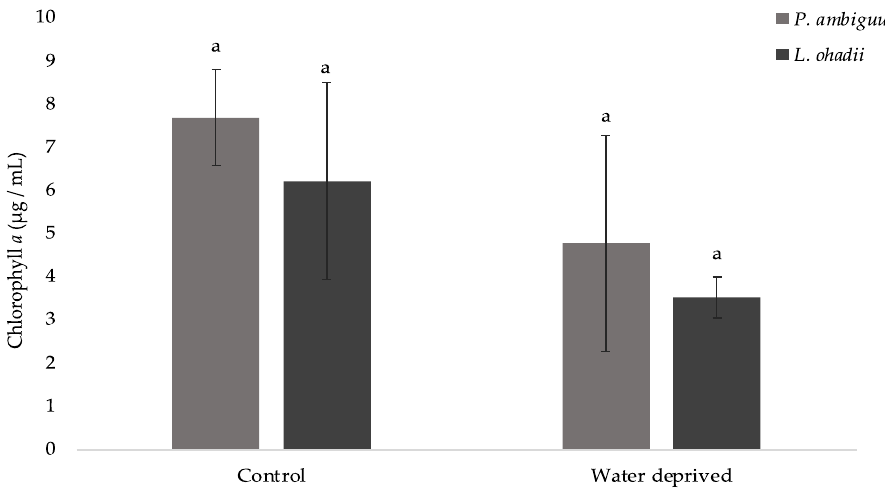
Figure 4. Chlorophyll a content in cyanobacterial biofilms (values represent the mean of N = 3, error bars represent SD). Different letters represent significant differences ( p < 0.05).